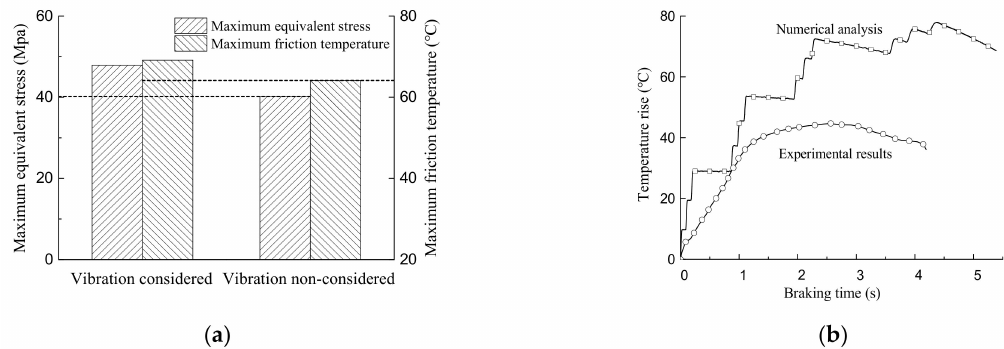
Figure 10. Comparisons of equivalent stresses and temperature at the contact surfaces of the brake disc considering and ignoring vibration. ( a ) Maximum equivalent stresses and temperature at the contact surfaces of the brake disc considering and ignoring vibration. ( b ) Theoretical and experimental temperature rise at the contact surface of the brake